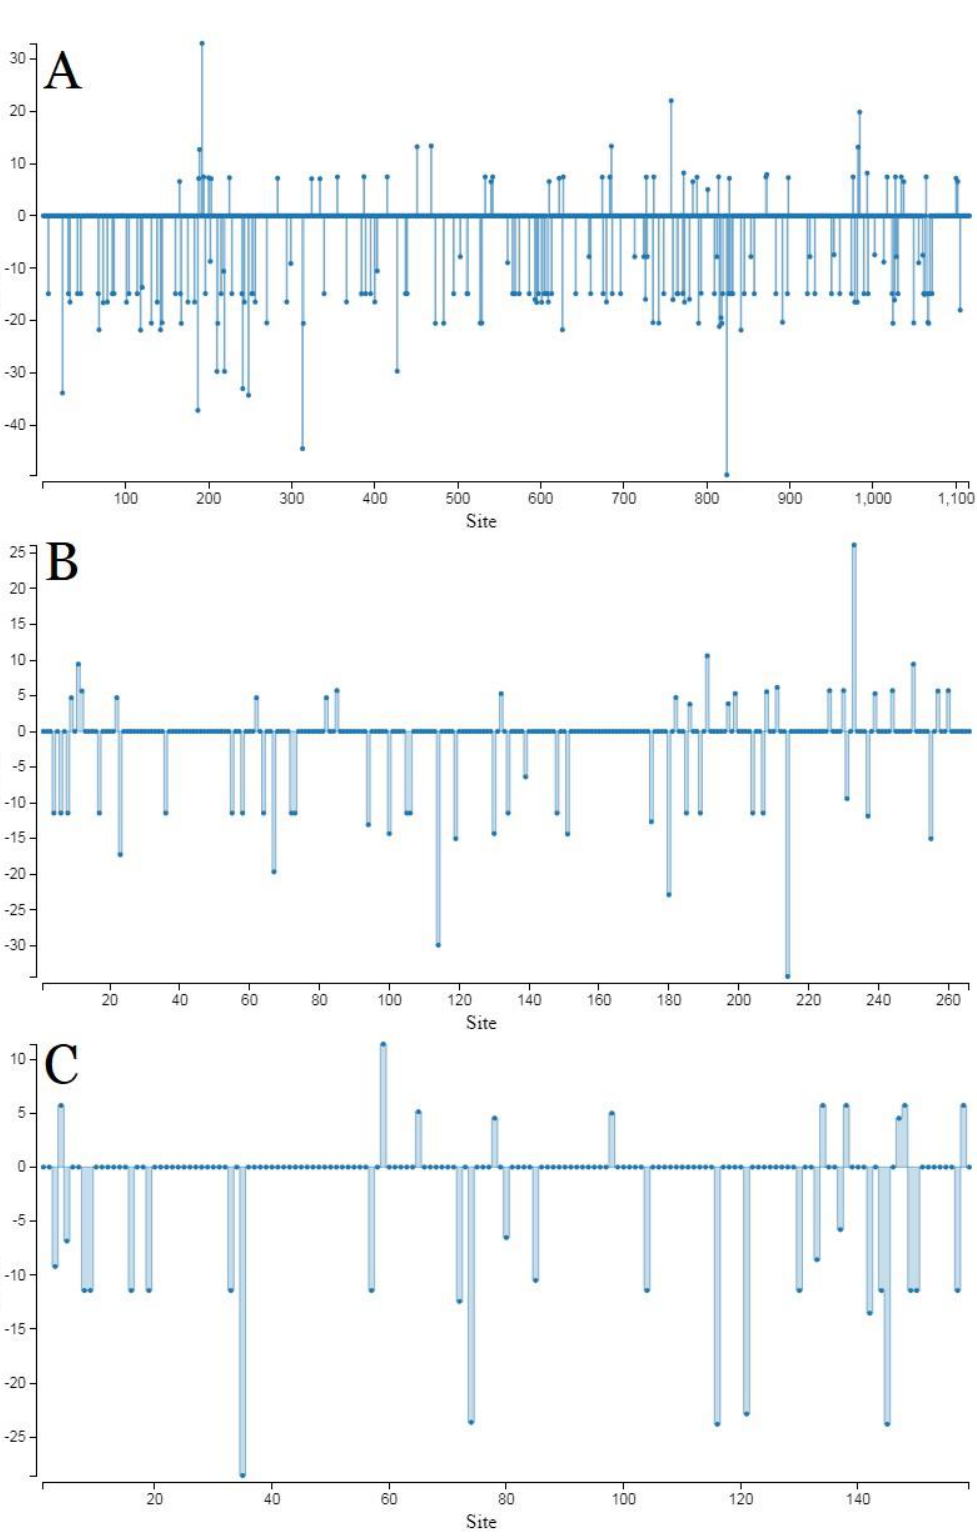
Figure 3. SLAC site graph to identify positive and negative codons/sites for ORF2 ( A ), ORF3 ( B ), and ORF4 ( C